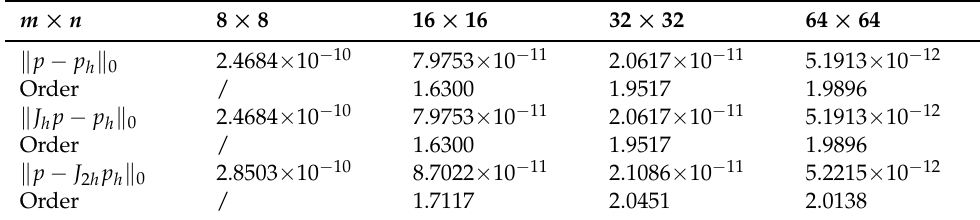
Table 8. The numerical errors and convergence orders at t = 10 of p